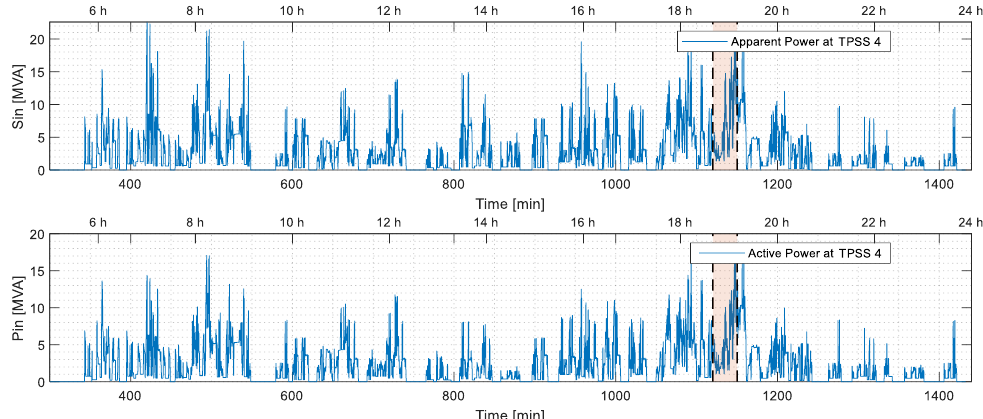
Figure 14. Apparent and active power consumption in TPSS 4 when TPSS 5 is out of service. In this scenario, TPSS 5 is out of service. When TPSS 5 is in failure mode during a period of time, the adjacent substations will handle the out of service period of TPSS 5. We selected the time period between 18:40 and 19:10 (from minute 1120 until minute 1150) to analyze the power factor (in Figure 15) and the power losses (in Figures 16 and 17) in the three-phase grid at the point of common coupling.